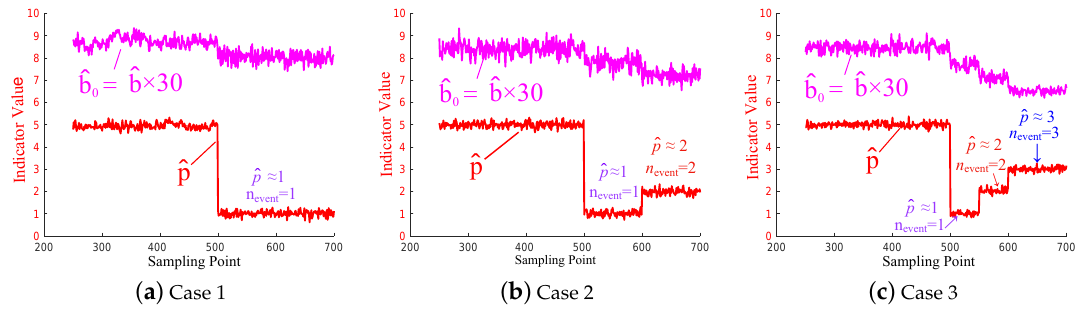
Figure 2. Case Study with Simulated Data. The estimated number of constituent components in a multiple event, i.e., ˆ p , is equal to the actual number of constituent components, i.e., n event that we assume in a multiple event.